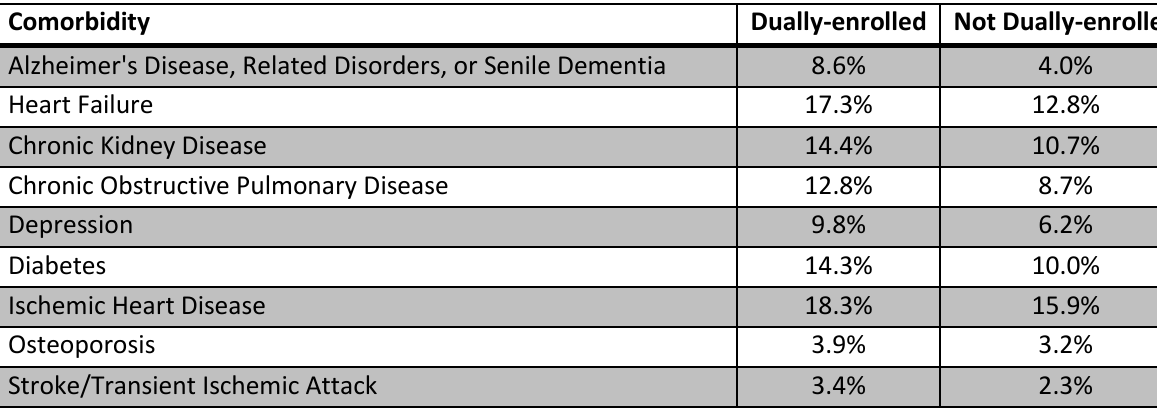
Table 5.1. Proportion of Beneficiaries with Select Conditions by Dual Enrollment Status Comorbidity